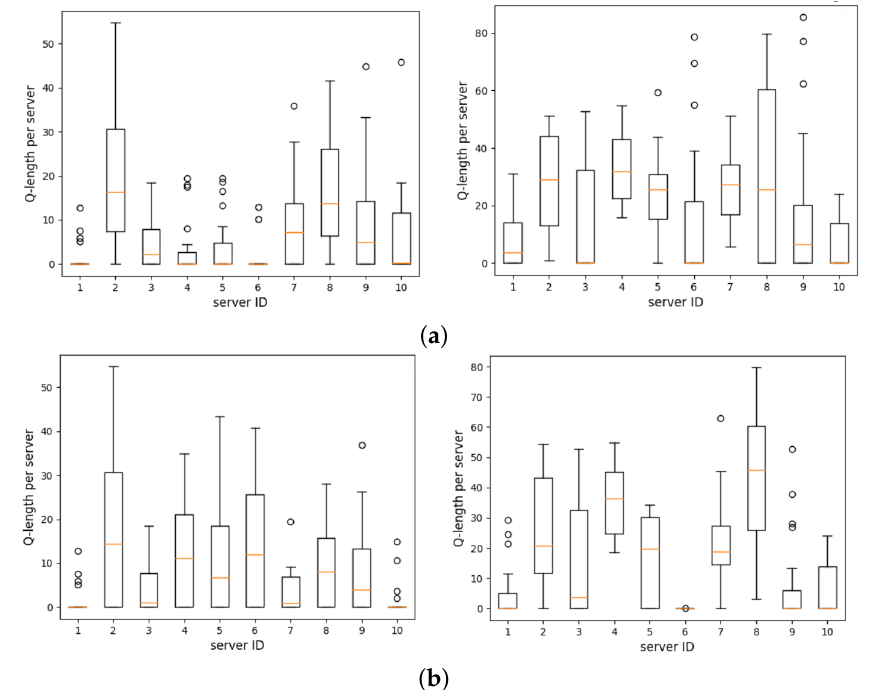
Figure 12. Length of the queue per server for 10 MECSs with workload rate = 1.5. ( a ) The neighbor- hood range is 4 ( q th = 0.5 or 0.7); ( b ) The neighborhood range is 6 ( q th = 0.5 or